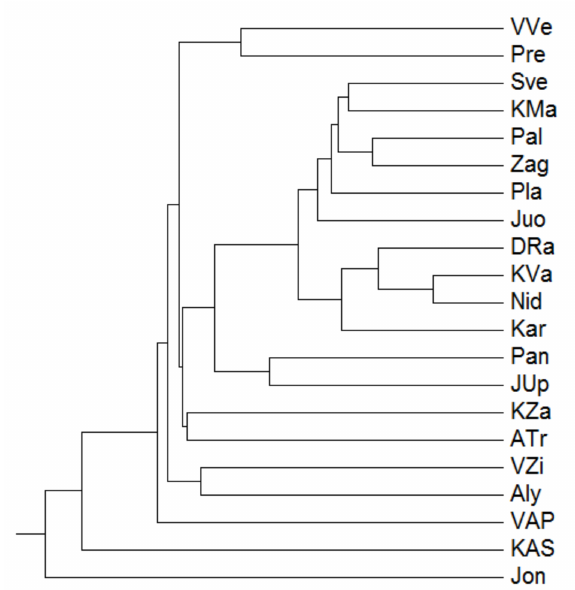
Figure 2. Dendrogram of AFLP loci relationships among 21 Lithuanian populations of small balsam ( Impatiens parviflora ) obtained using Nei’s (1978) genetic distances and UPGMA algo- rithm. Populations are named by three letter acronyms (see Figure 1 for details of geographical location of